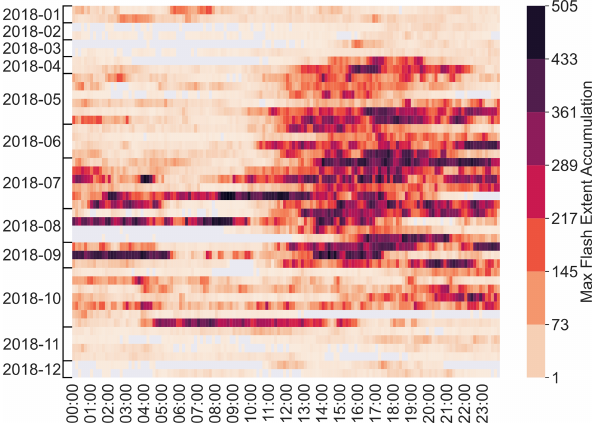
Figure 3. Domain-wide maximum FEA for each 10min of each day of the training dataset. The FEA is calculated on 7km per 7km